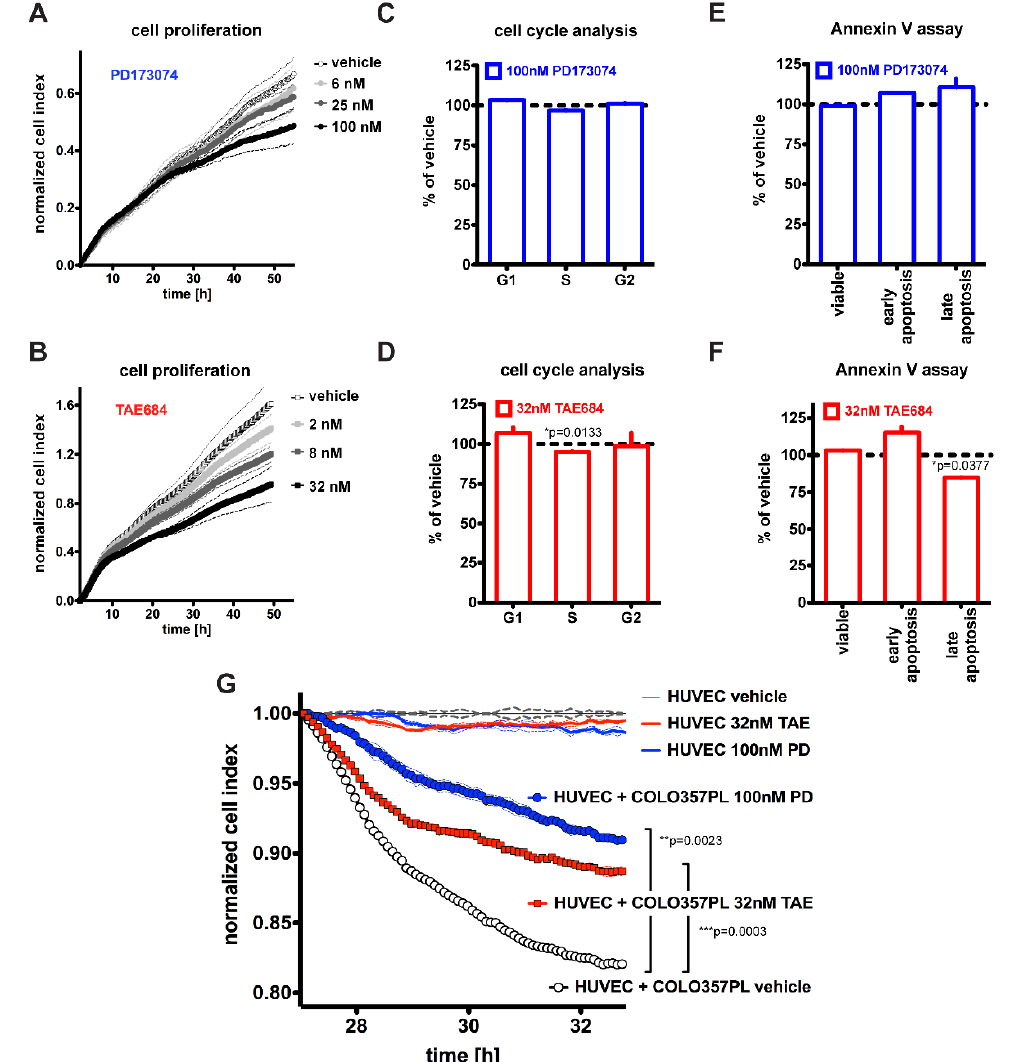
Figure 1. Response of COLO357PL cells to PD173074 or TAE684 in vitro. ( A , B ): Proliferation assays. COLO357PL cells were plated in the presence of drug in duplicates and measurements were made every 15 min. Cells were treated with PD173074 at 6 nM, 25 nM or 100 nM ( A ), or TAE684 at 2 nM, 8 nM or 32 nM ( B ). DMSO diluted in cell growth media served as control. Proliferation curves are shown as mean ± SEM. Two-way ANOVA was used as a statistical test and no significant p -values for treatment were observed. ( C , D ): Vindelov staining for cell cycle, and ( E , F ) Annexin V staining for apoptosis detection was analyzed by flow cytometry. Cells were treated for 48 h with PD173074 (100 nM) or TAE684 (32 nM). Vehicle treatment was DMSO diluted in cell growth media. Experiments were performed in duplicates. Mean ± SEM is shown. Unpaired two-tailed t -test was used and significant p -values for the comparison of kinase inhibitor treatment versus vehicle control are indicated. ( G ): Endothelial invasion assay. HUVECs form a stable monolayer prior to addition of drug +/ − COLO357PL cells. The cell index was measured every 5 min for the first 6 h after addition of cancer cells. The experiment was performed in duplicates. Mean ± SEM is shown. Two-way ANOVA and p -values for treatment are